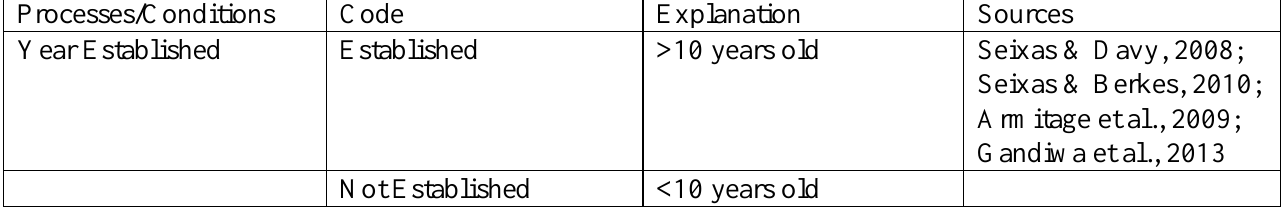
Table 1.1. Description of institutional processes, or conditions, and their